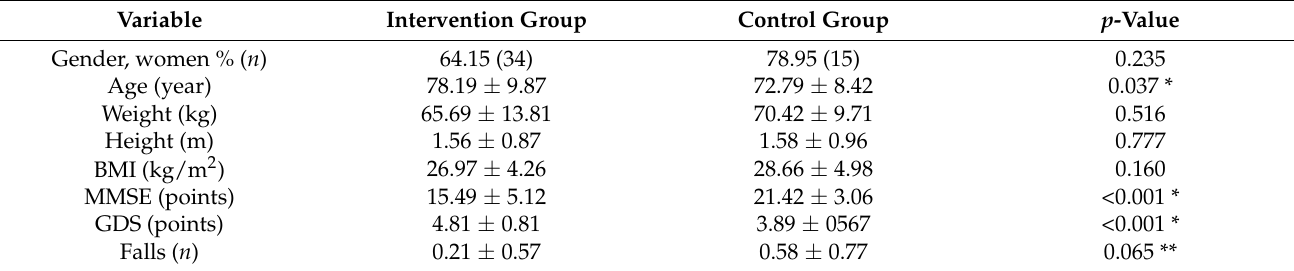
* Indicates significant differences between groups; ** Levene’s contrast test showed significant differences and since the highest variance was found in the lowest group (control group), correction in degrees of freedom was applied using the Welch test. BMI, body mass index; MMSE, Mini-Mental State Examination; GDS, Global Deterioration